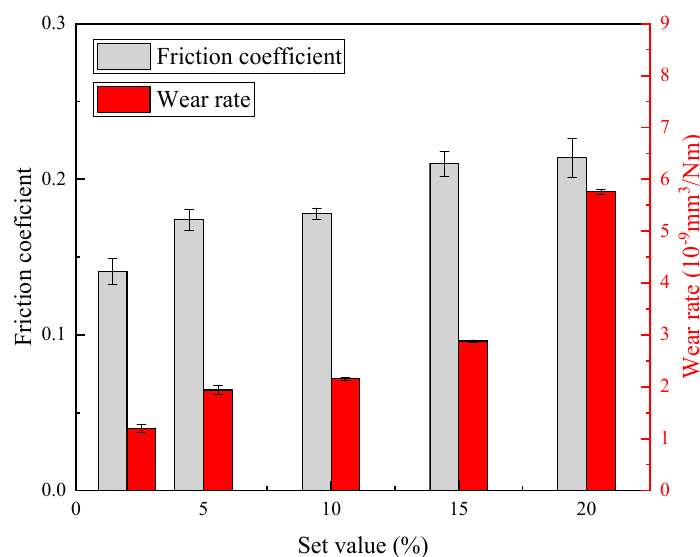
Figure 13. The average friction coefficient and wear rate of the Cr-DLC films deposited at different set values.